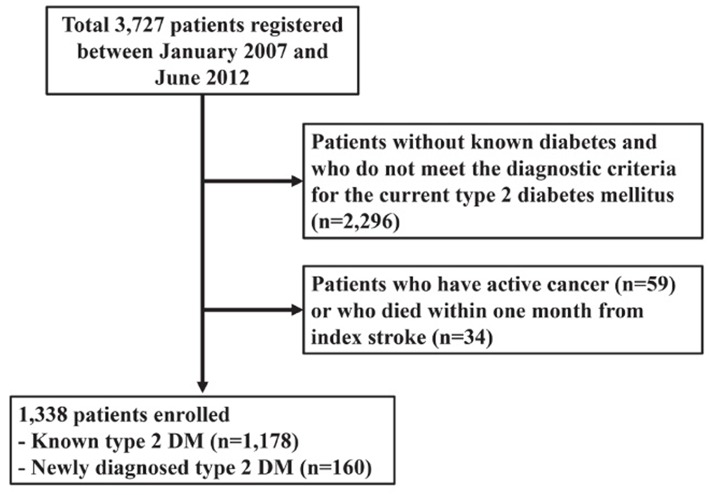
Flow chart of patient selection.